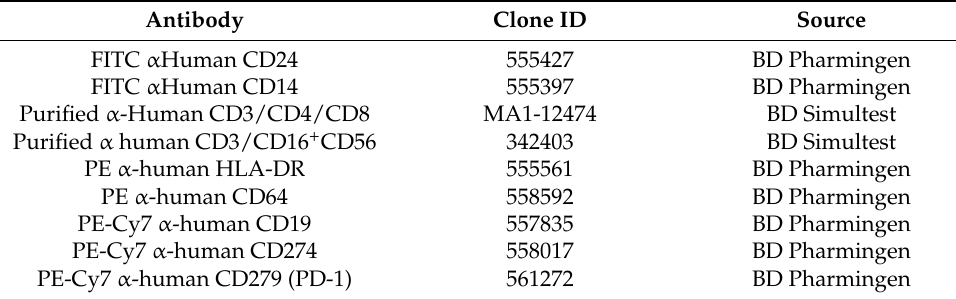
Table 1. Antibodies used throughout the research project.